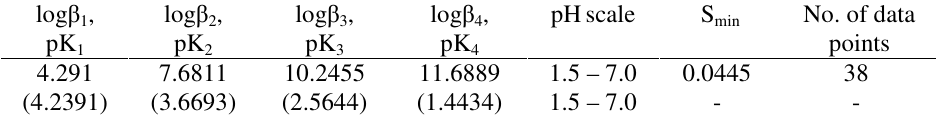
Table 1. Results of BEST FIT model for complexes Y(III)-2-oxo-1-pyrrolidine acetamide